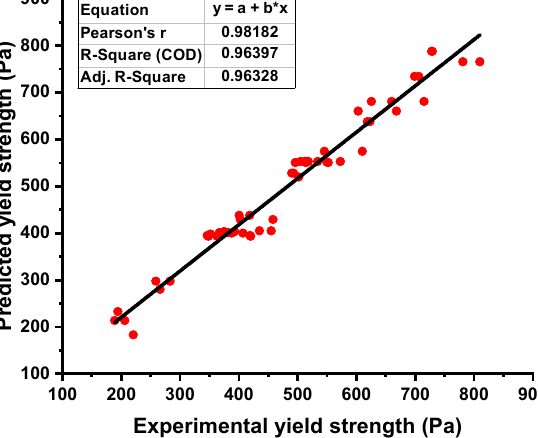
Figure 5. Yield stress relationship for the actual and predicted result of R-F model.